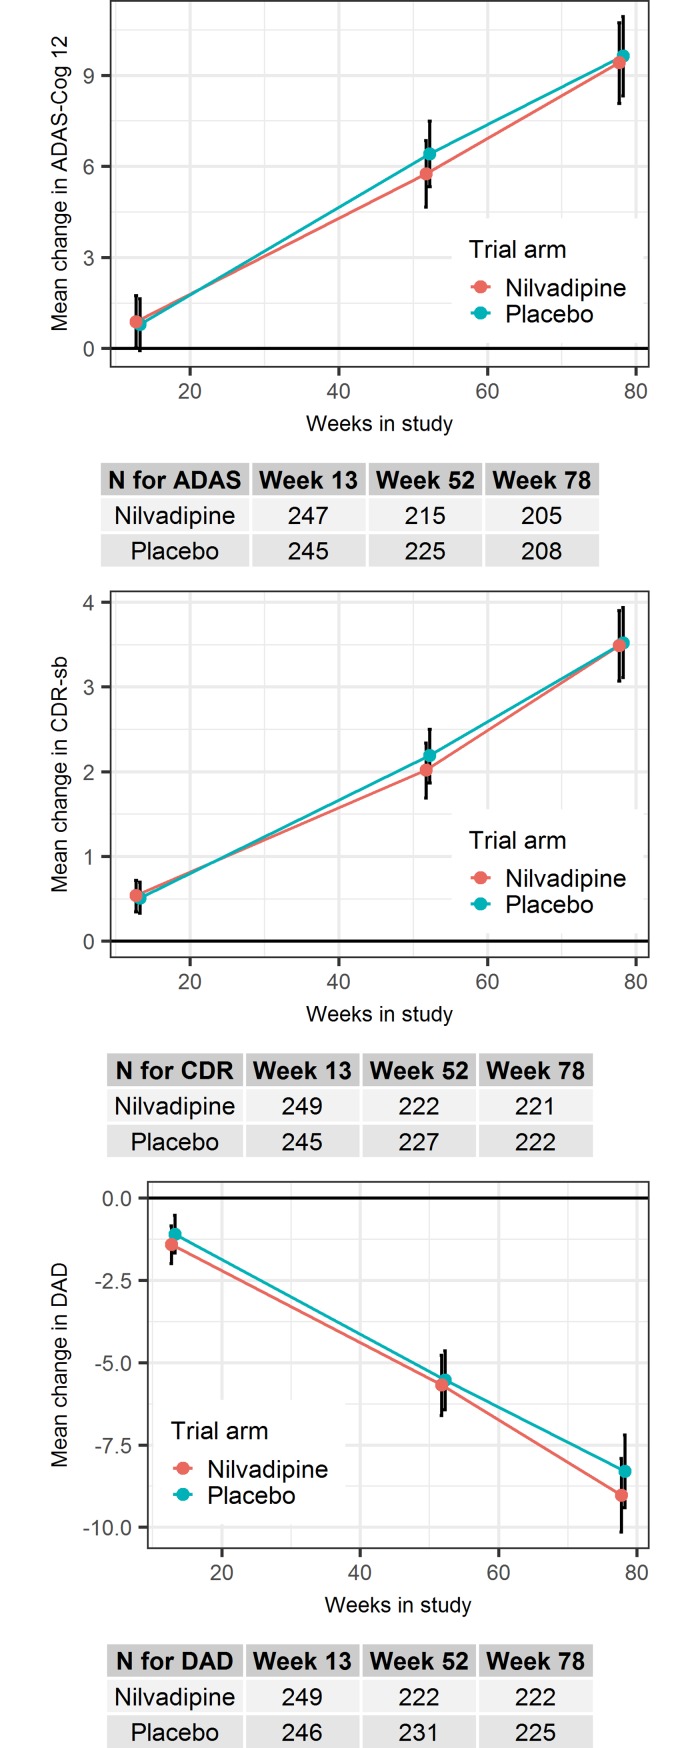
Estimated marginal means and 95% confidence intervals of the per-visit change from baseline in cognition and functional performance, as measured by the primary and key secondary outcomes, respectively.ADAS/ADAS-Cog 12, Alzheimer's Disease Assessment Scale Cognitive-12; CDR/CDR-sb, Clinical Dementia Rating Scale sum of boxes; DAD, Disability Assessment for Dementia.